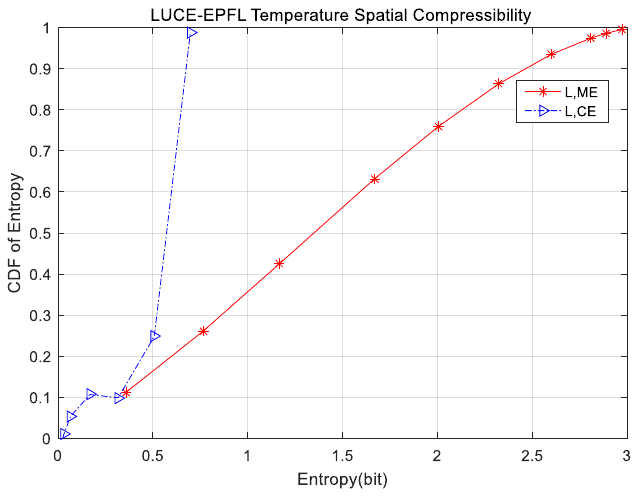
Figure 1. Spatial compressibility of LUCE-EPFL temperature.